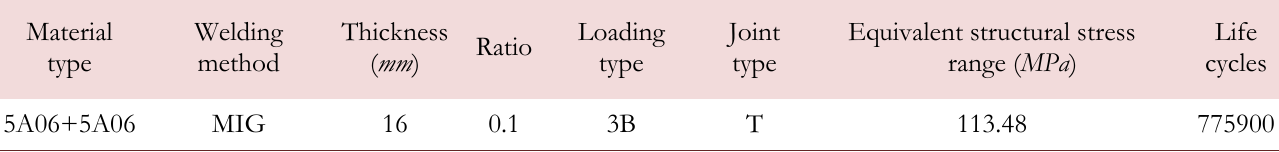
Table 12: Fatigue test data of aluminum alloy T-welded